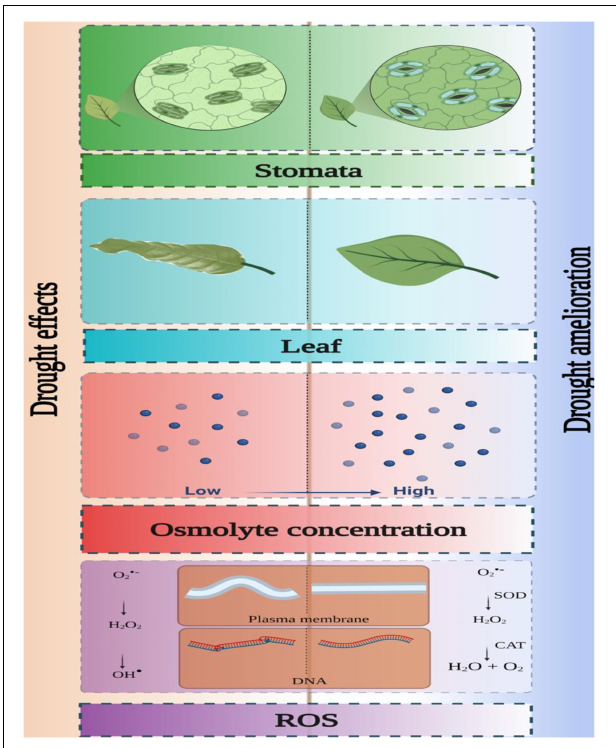
FIGURE 4 | Drought stress alleviation by